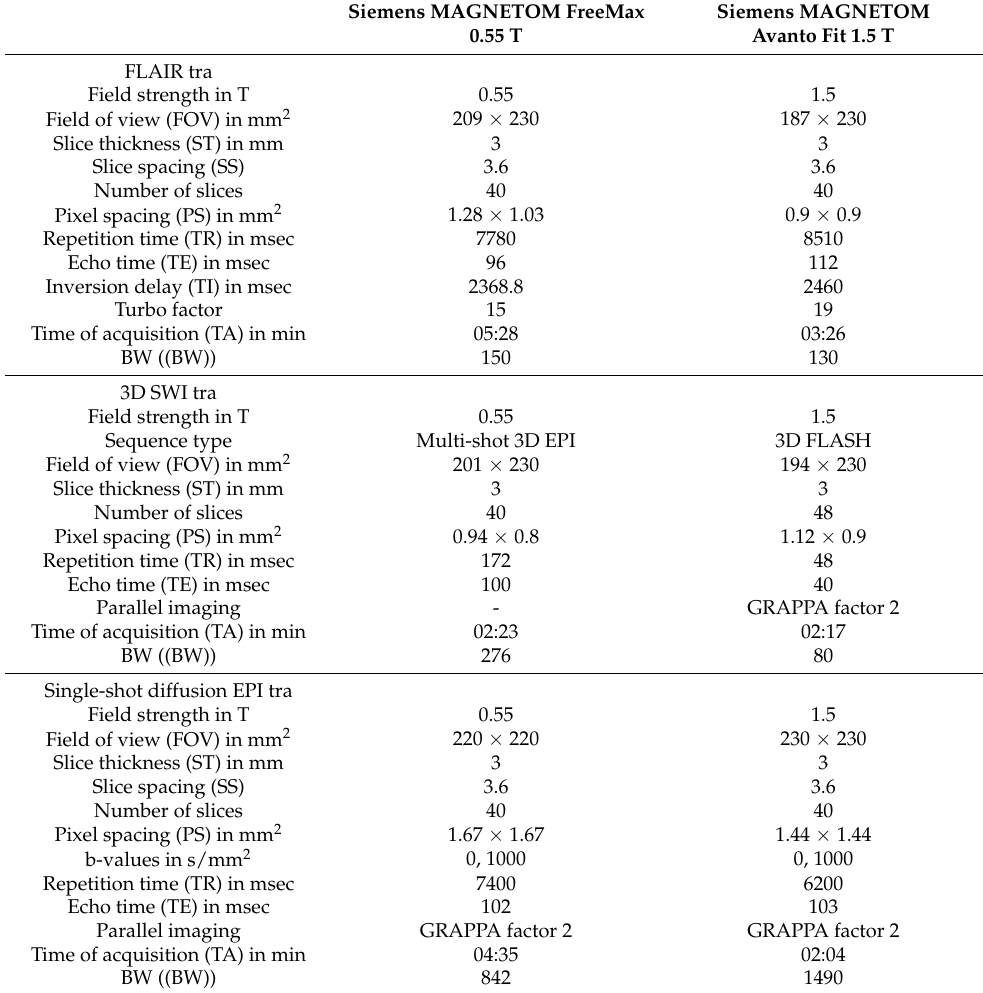
Table 1. Scan protocols Siemens MAGNETOM Avanto FIT 1.5 T and Siemens MAGNETOM FreeMax 0.55